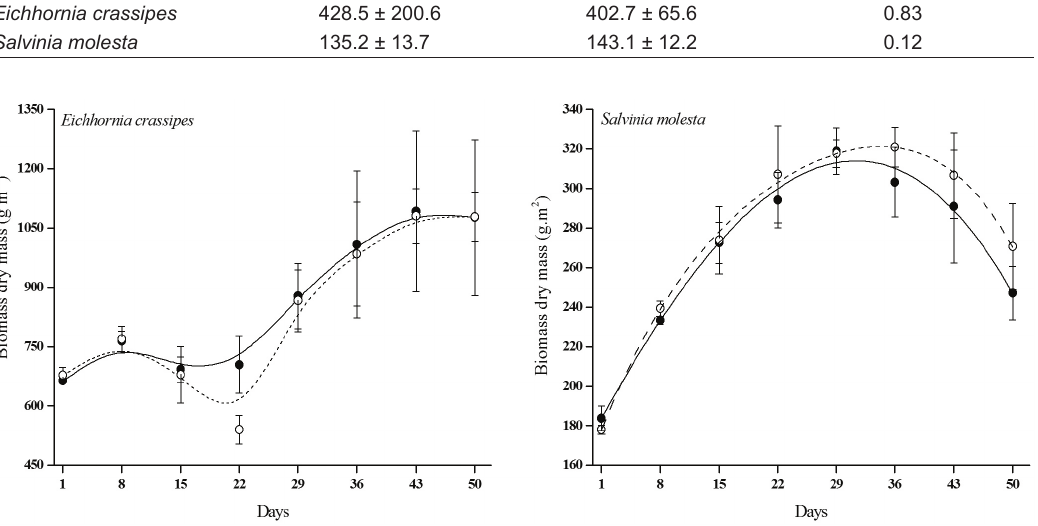
Figure 2. Growth curves of Eichhornia crassipes and Salvinia molesta in the higher ( ● ) and lower ( ○ ) nutrient